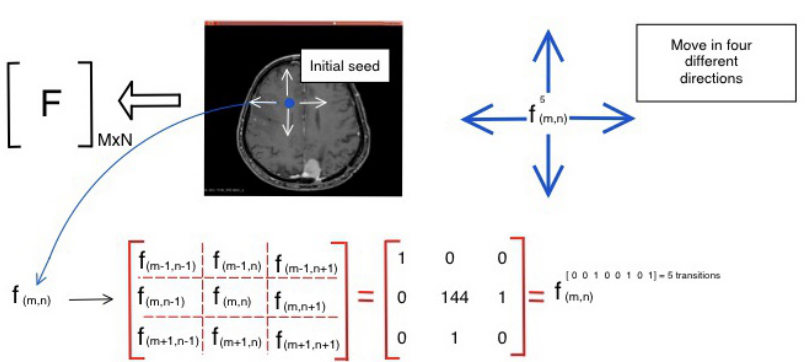
Figure 2. Summary of the local binary pattern procedure. The procedure begins with the indication of an initial seed, provided by the operator. Then neighboring pixels are selected and set to 0 or 1 value depending on their value. The number of transitions is stored, then the procedure is repeated, moving from the initial seed in all 2D